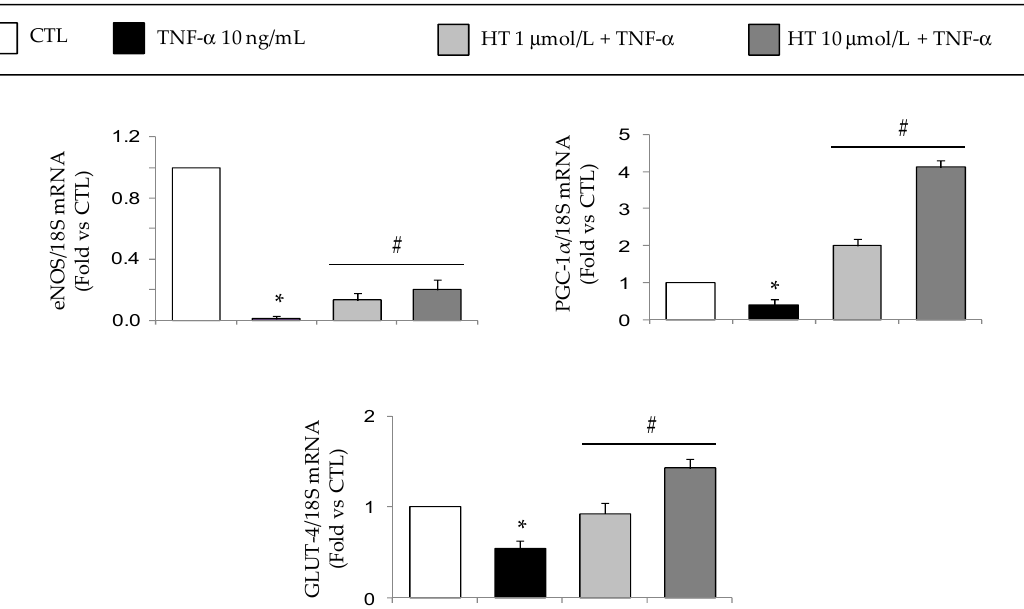
Figure 3. Modulation by HT of mRNA expression levels of genes associated with adipocyte metabolism and mitochondrial biogenesis. SGBS adipocytes were pretreated with HT (1 h) at the concentrations indicated, and then treated with 10 ng/mL TNF- α for 18 h. Total RNA was extracted from cells, and mRNA levels of eNOS, PGC-1 α , and GLUT-4 were measured by qPCR using specific primers and probes and normalized to 18S RNA. Data (means ± SD, n = 3) are expressed as fold induction over untreated control (CTL). * p < 0.05 vs CTL. # p < 0.05 vs TNF- α alone.